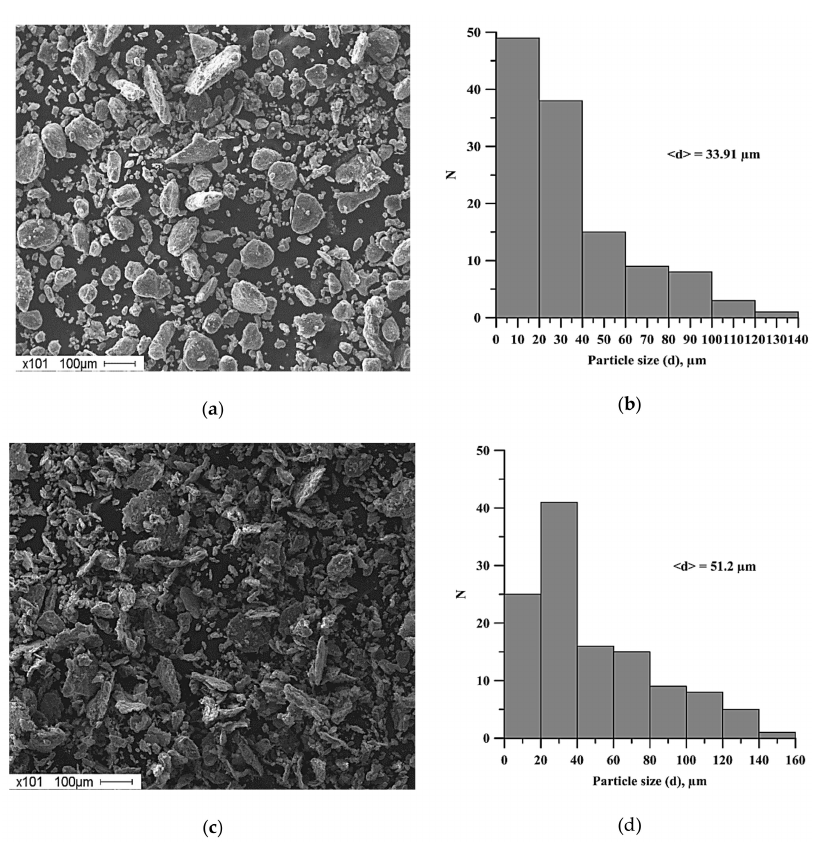
Figure 5. SEM images of the structures of powder mixtures of Al-Ti-B and histograms of the distribution of particles of the mixtures: ( a )-( b ) after 180 s planetary milling, ( c )-( d ) after 2400 s planetary milling. We assumed that the particle deformation a ff ected the compaction process of the powder mixture. Actually, when changing the time of planetary milling, the specimen density also changed, and this dependence is extreme; it is given in Figure 6.